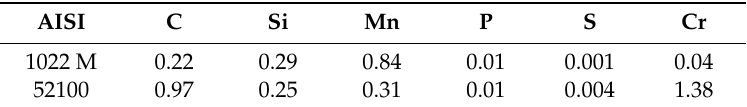
Table 1. Chemical composition of AISI 1022M and AISI 52100 determined by optical emission spectrometry in